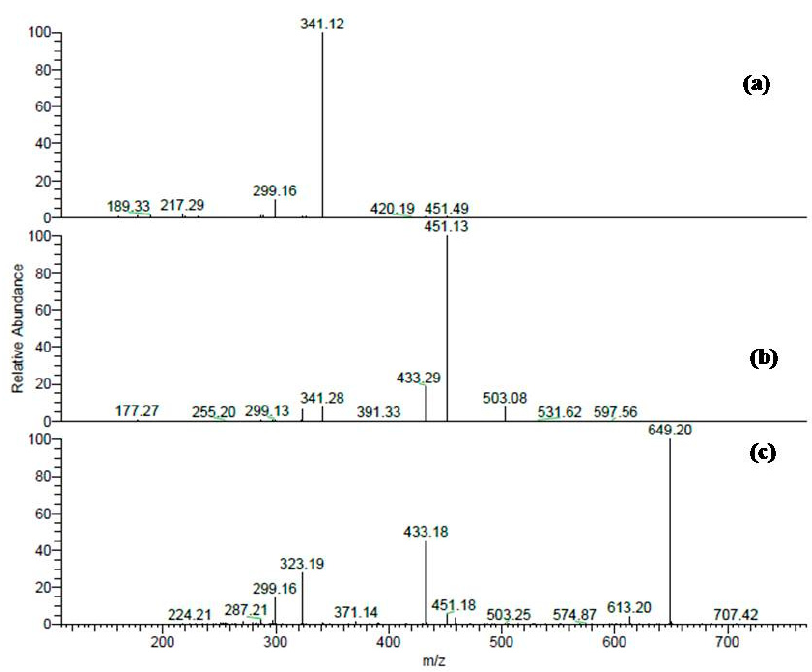
Figure 3. ( a ) MS/MS fragmentation of cinchonain-I at [M − H] − ( m / z ) at 451; ( b ) MS/MS fragments of cinchonain-I hexoside at [M − H] − ( m / z ) at 613; ( c ) MS/MS spectra of cinchonain-I